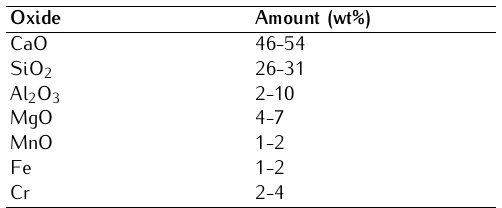
Table 2. Typical chemical composition of AOD slag, expressed as oxides